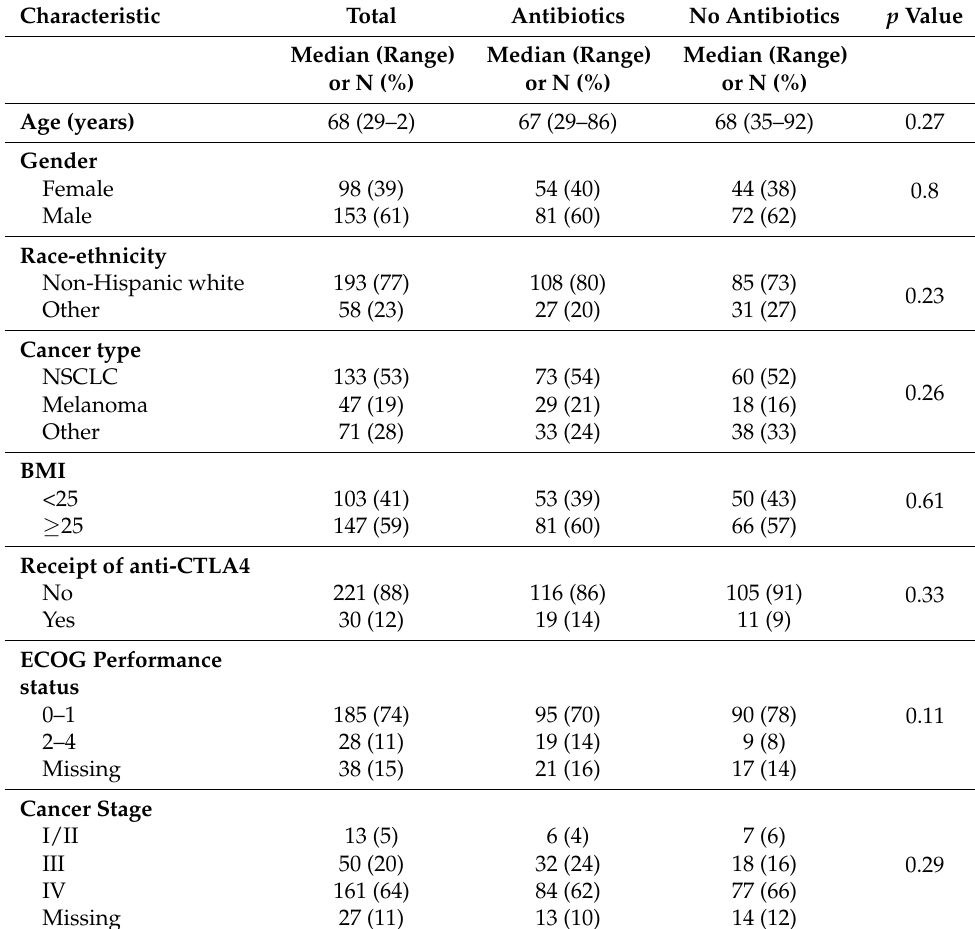
Table 1. Clinical characteristics according to antibiotic